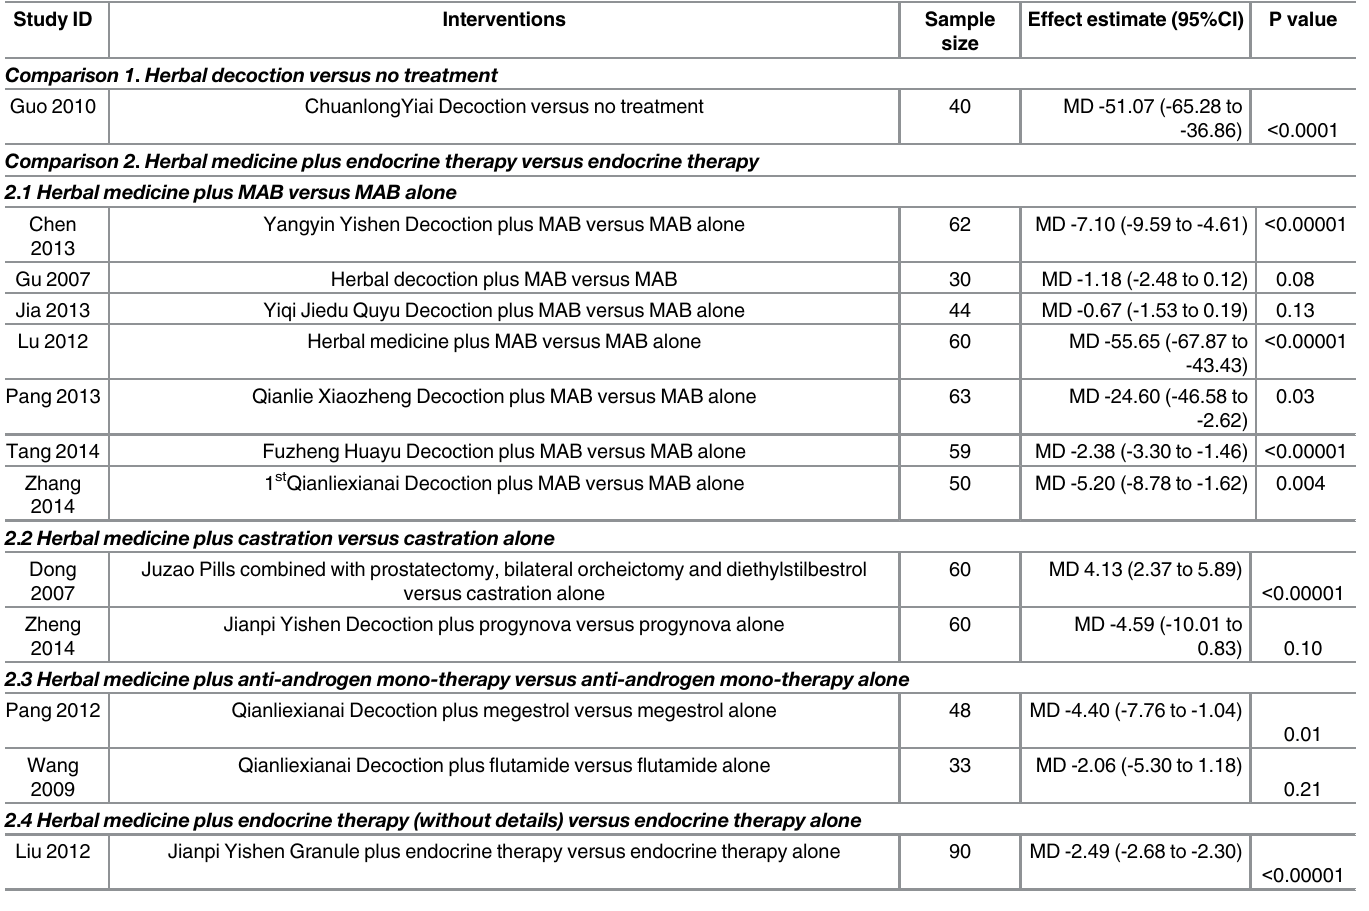
Table 3. Estimate effect for Prostate Specific Androgen of the 17 included